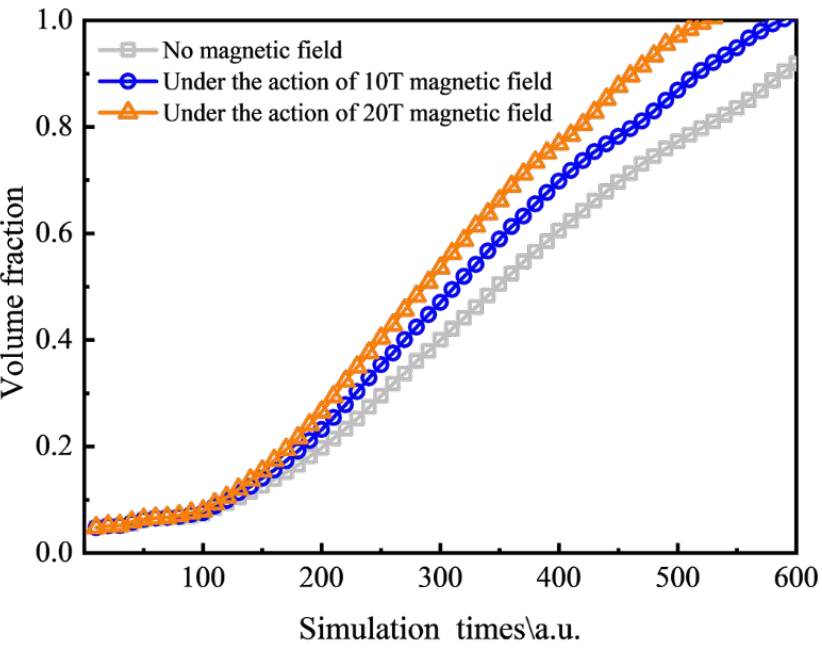
Figure 7. The kinetic curves of martensite transformation for different magnetic field intensities.